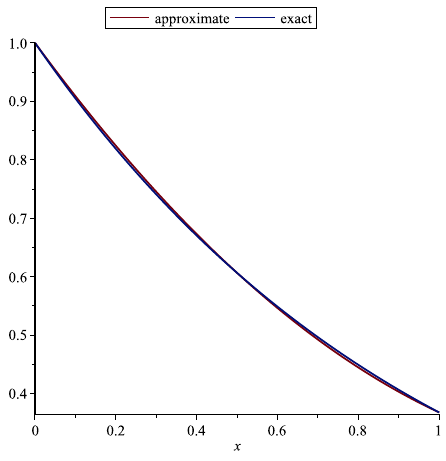
Figure 8. The approximate and exact solution of u 2, approx ( x ) for Example